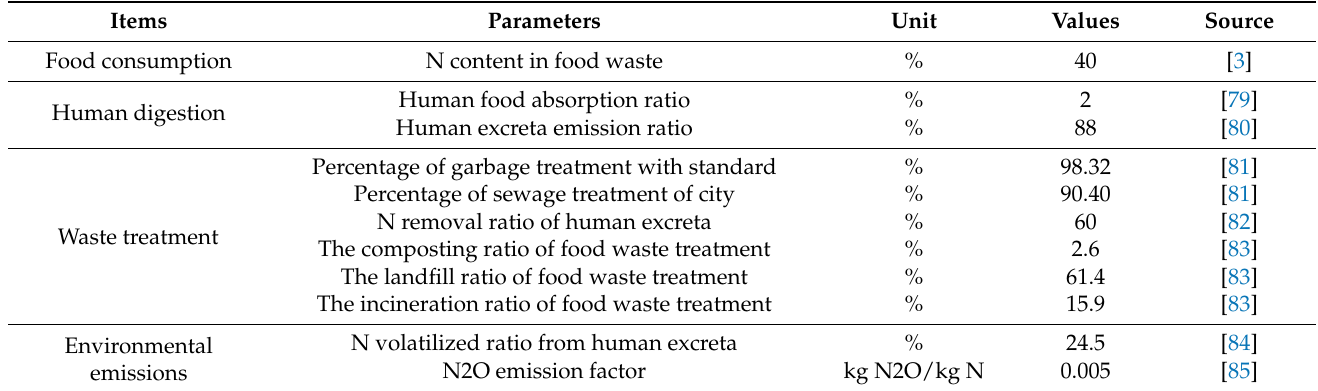
Table A2. Required parameters for calculating environmental nitrogen